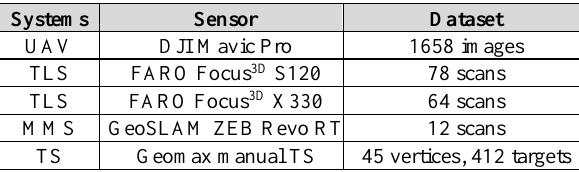
Table 1. General overview of sensor employed, and data collected